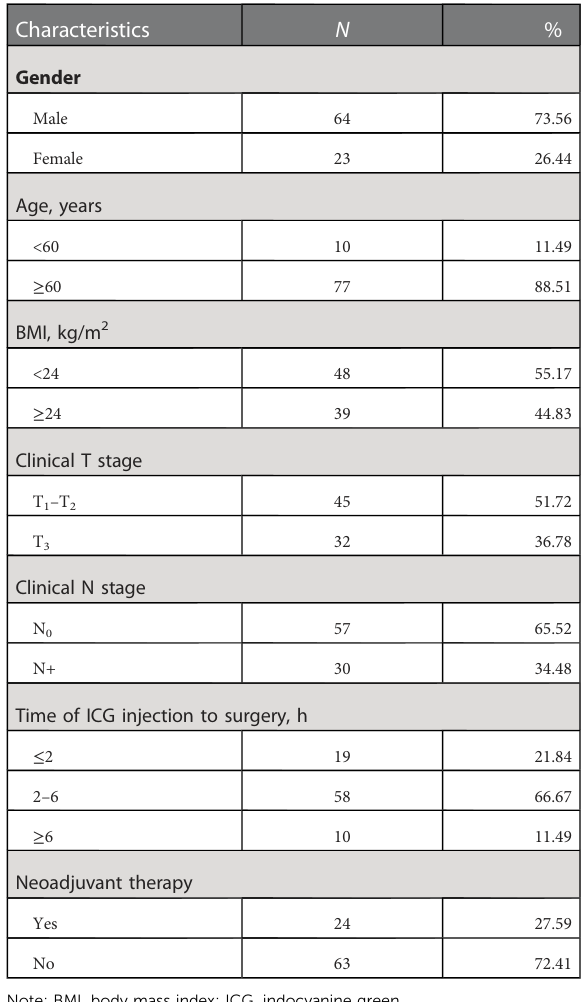
TABLE 1 The clinical and pathological characteristics of the study patients. Characteristics